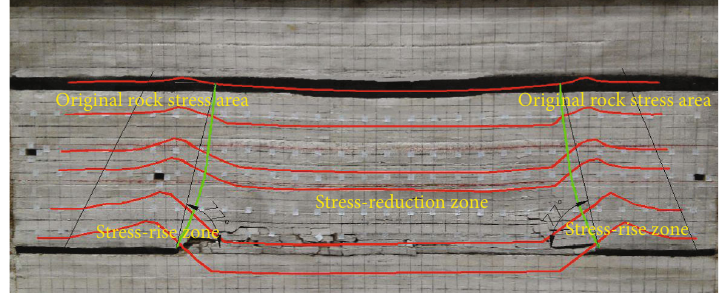
Figure 9: Stress zoning diagram.